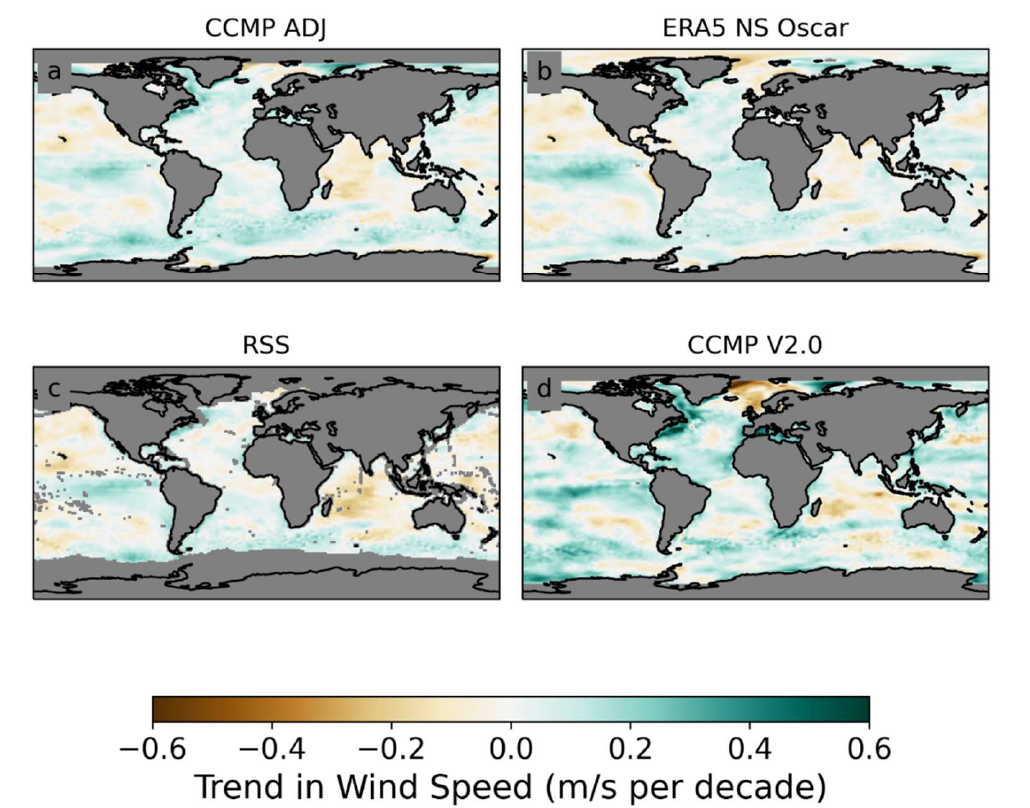
Figure 17. Maps of Trends in wind speed (1993–2019) for two versions of CCMP ( a , d ), ERA5 NS Oscar ( b ), and RSS radiometer winds ( c ). CCMP ADJ is in much better agreement with ERA5 and with the radiometer winds than CCMP 2.0.